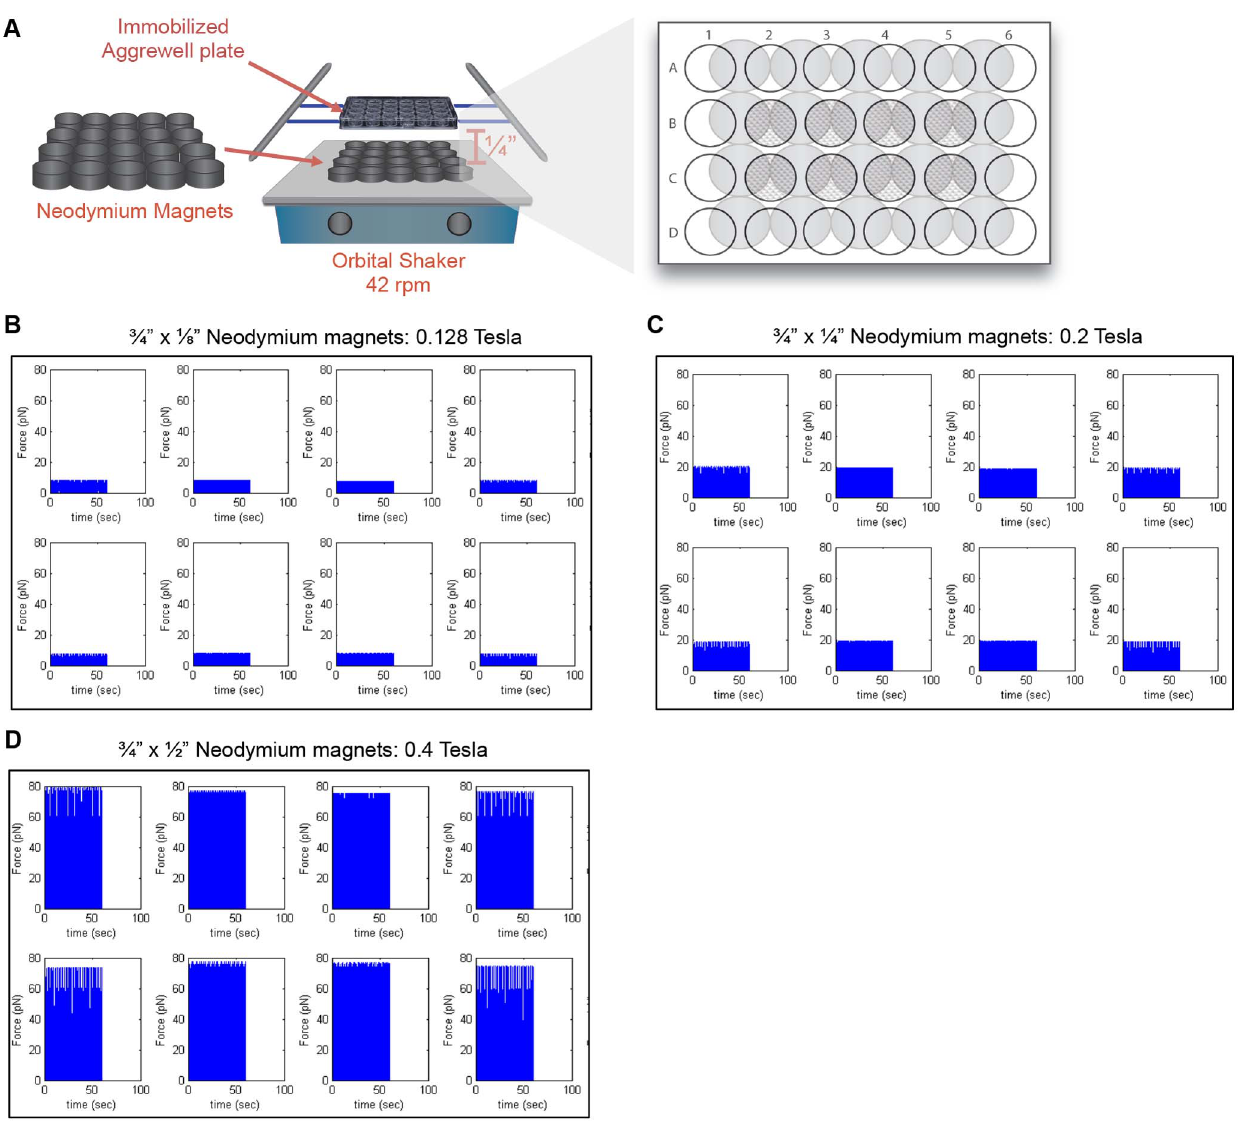
Fig. 2. Magnetic attraction apparatus setup. (A) An array of N42 permanent neodymium magnets with different thicknesses were arranged on an orbital shaker. The force applied to the cells was modeled using a customized Matlab program over the course of 1 min (42 cycles) at 0.128 Tesla (B), 0.2 Tesla (C), and 0.4 Tesla